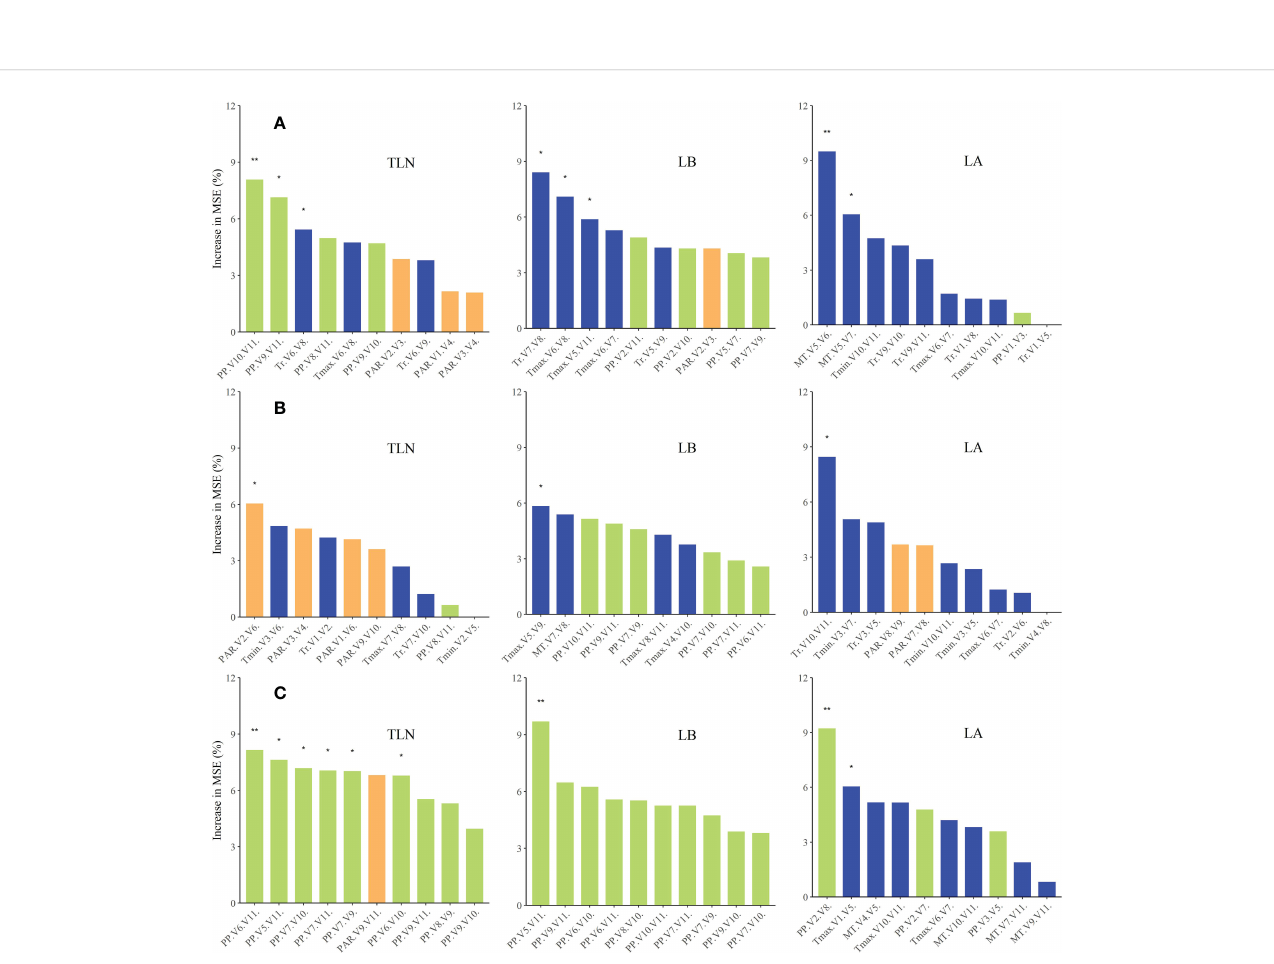
FIGURE 6 Relative contributions (percent increase of the MSE) of various meteorological factors as drivers of variations in TLN, LB, and LA of the three maize cultivars. Percent increases in the MSE of different variables were used to estimate the importance of these predictors, and higher MSE% values indicated greater importance of the predictors. MSE, mean squared error (A, FK139; B, JNK728; C, ZD958). * and ** are used to indicatesigni fi cance levels at 0.01 < P < 0.05, 0.001 < P < 0.01, and P < 0.001,respectively. In addition, ns refers to P ≥ 0.05.